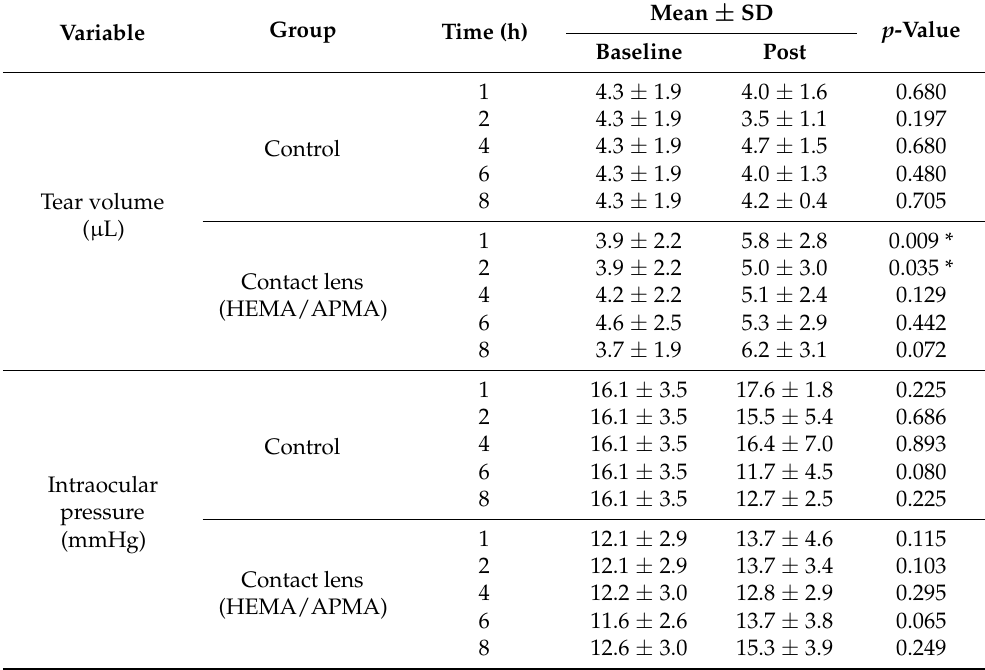
Figure 8. Normalized effect of melatonin-eluting contact lenses on the tear volume of rabbits at the baseline ( n = 12) and after 1, 2, 4, 6, and 8 h of wearing the contact lenses ( n = 12, 12, 9, 6, and 3, respectively). The control group represents 3 rabbits without contact lenses. * p < 0.05, ** p < 0.01, Wilcoxon test, comparison with the baseline. Table 1. Raw values of the tear volume and intraocular pressure of rabbits at the baseline ( n = 12) and after (Post) 1, 2, 4, 6, and 8 h of wearing the melatonin-eluting contact lenses ( n = 12, 12, 9, 6, and 3, respectively). The control group represents 3 rabbits without contact lenses. * p < 0.05, Wilcoxon test, comparison with the baseline.